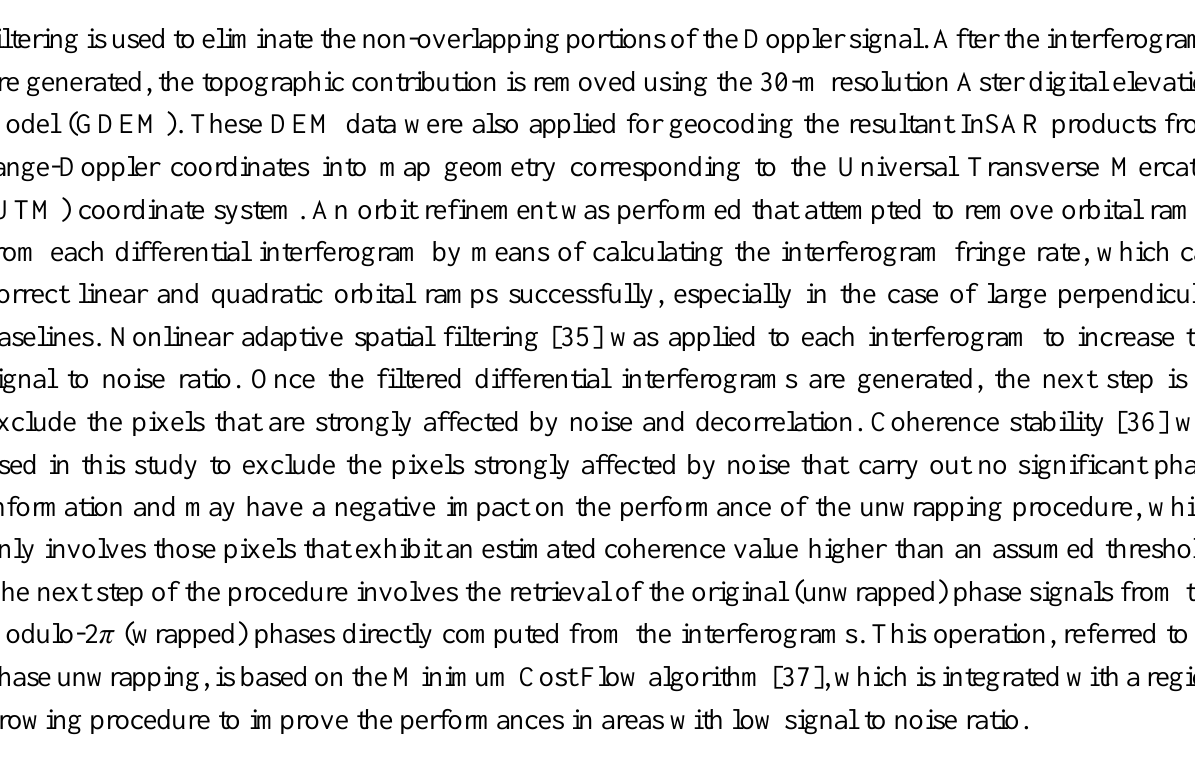
Figure 4. Baseline-time plots relevant to the PALSAR images and interferograms used in this